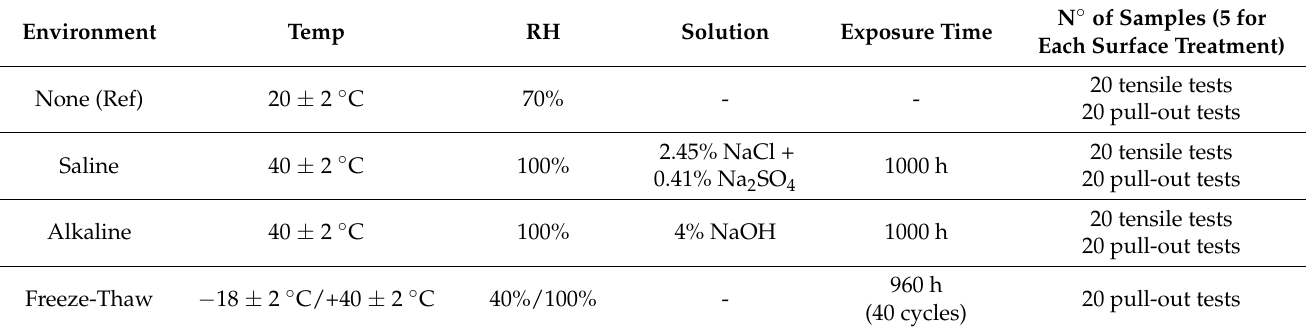
Table 3. Artificial aging test environments.